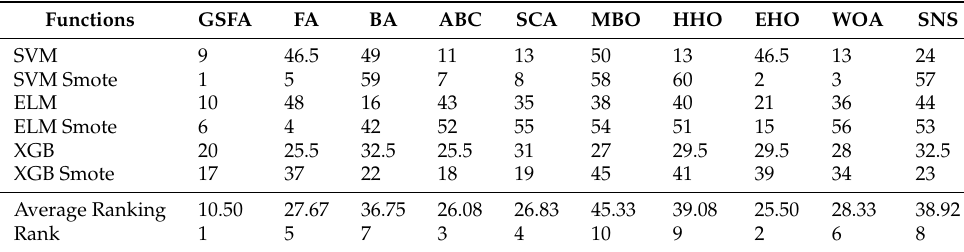
Table 20. Friedman aligned test ranks for the compared algorithms.